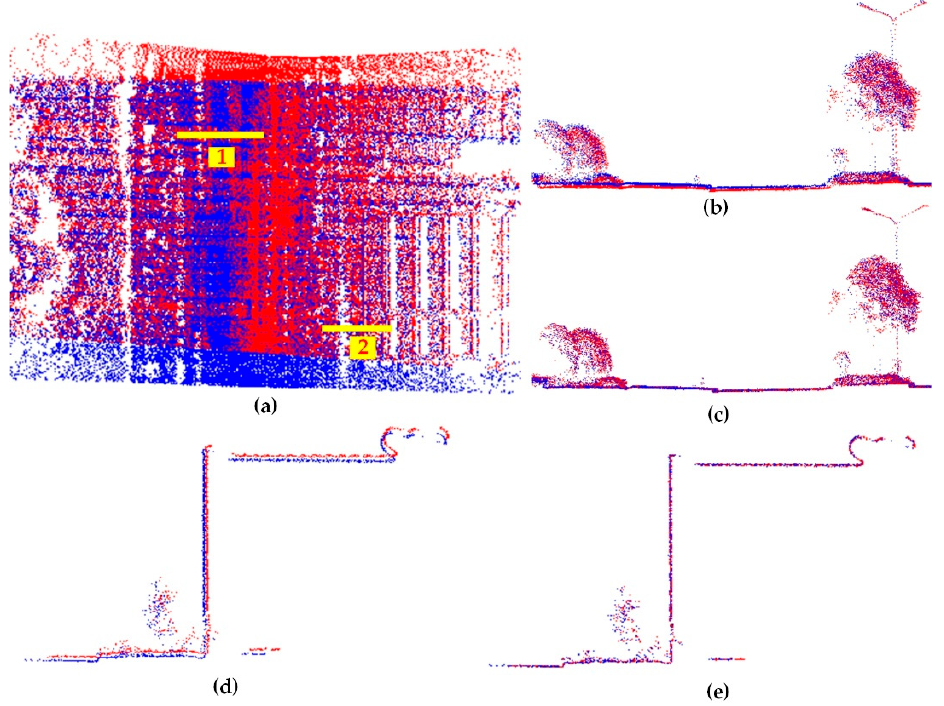
Figure 7. Multi-strip point clouds before and after boresight angle calibration in “ULS1”. ( a ) raw point clouds; ( b ), ( c ) point clouds of cross section 1 and cross section 2 respectively before boresight calibration; ( d ), ( e ) point clouds of cross section 1 and cross section 2 respectively after boresight calibration. Points scanned from different strips have different colors.